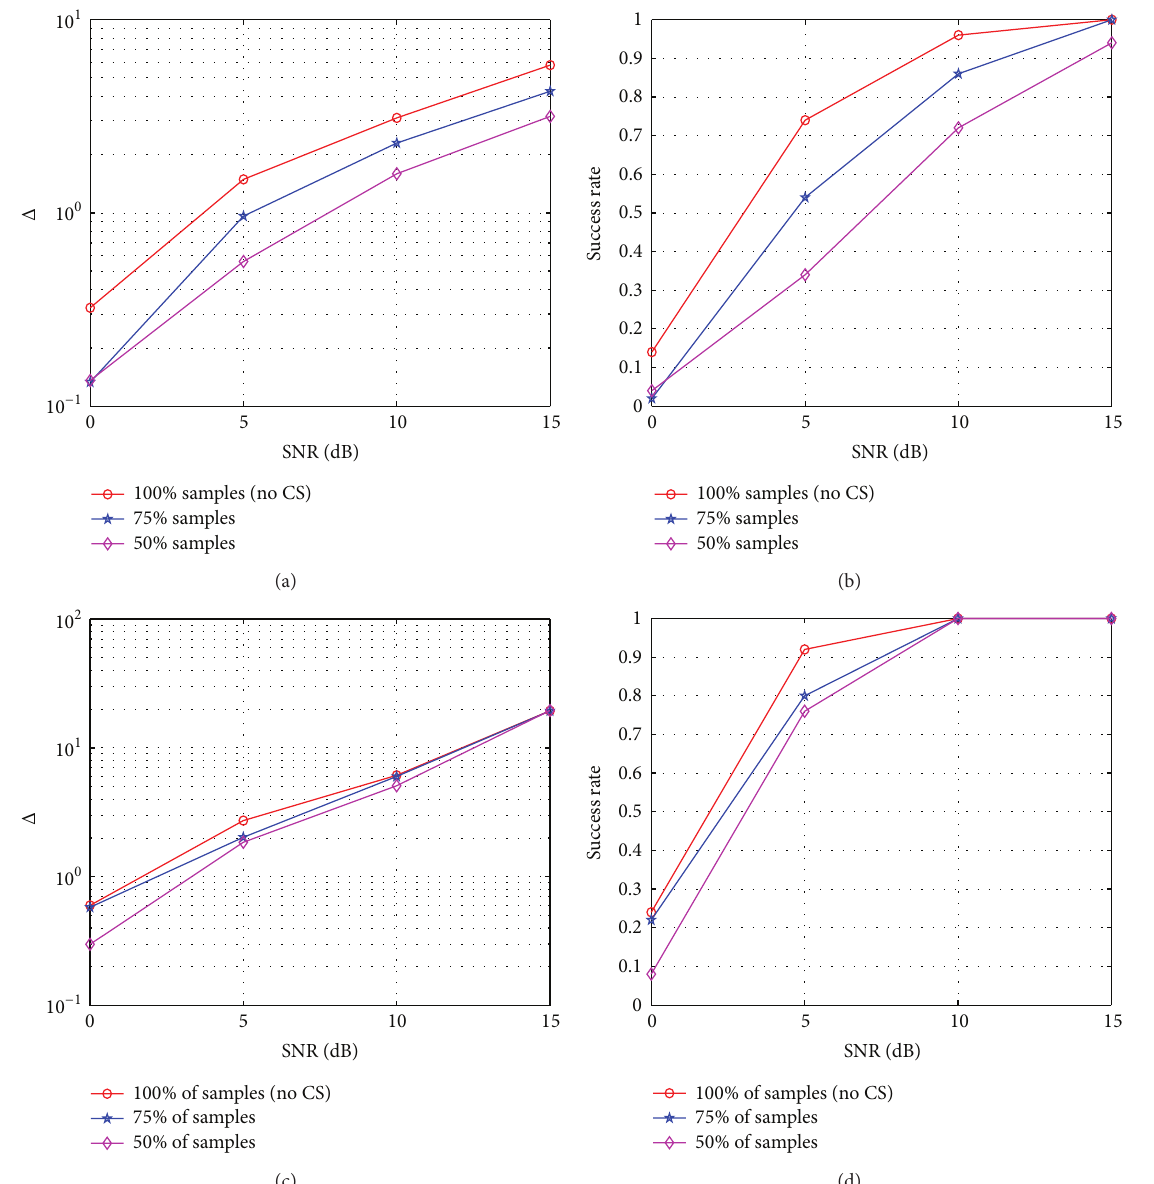
Figure 9: Comparison of metrics versus SNR for different percentages of samples. Grid distance is 10m. (a) Group-MP, Δ ; (b) Group-MP, success rate; (c) BSBL- ℓ 1 , Δ ; (d) BSBL- ℓ 1 , success rate.